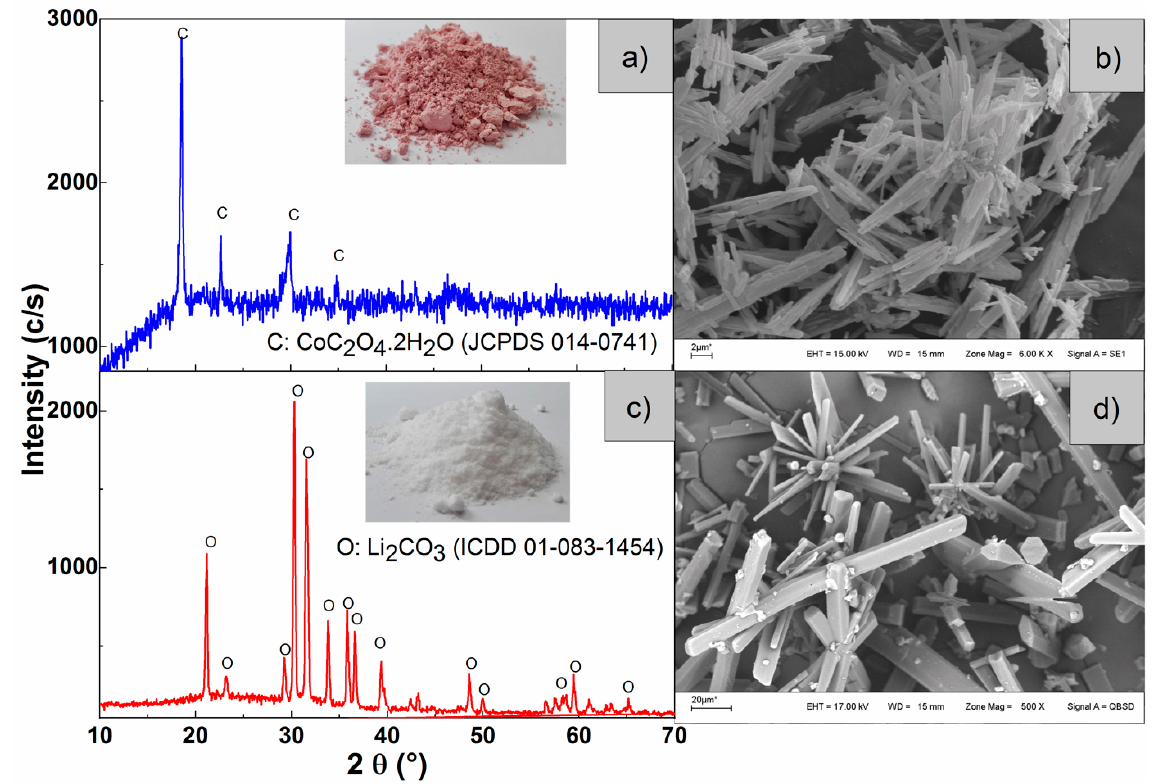
Figure 6. Diffractograms and micrographs of the synthesized solids. ( a ) XRD and ( b ) SEM of the cobalt oxalate, ( c ) XRD, and ( d ) SEM of the lithium carbonate.